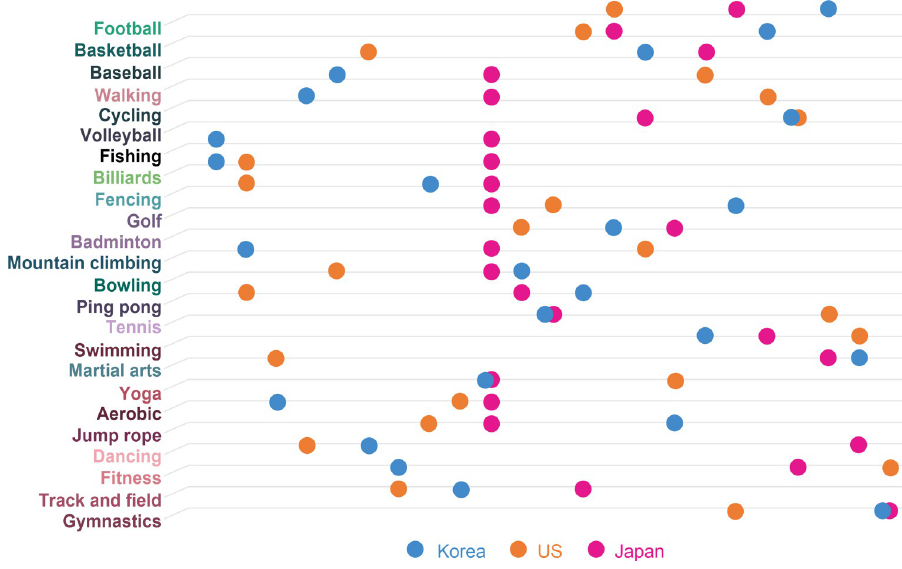
Fig 12. Comparison with textbooks.